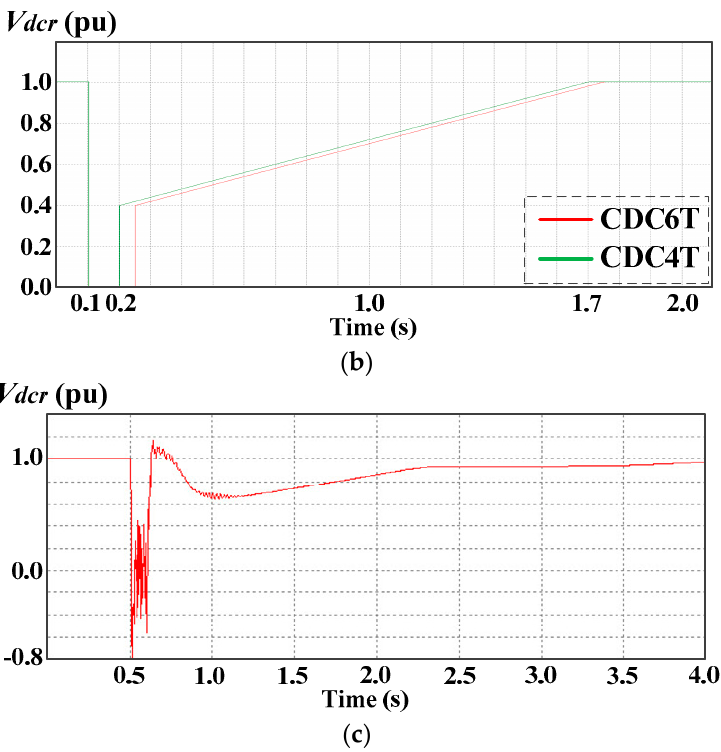
Figure 13. Rectifier DC voltage for a three-phase ground fault: ( a ) PSCAD, proposed, and conven- tional; ( b ) CDC4T and CDC6T; ( c ) CDC7T.